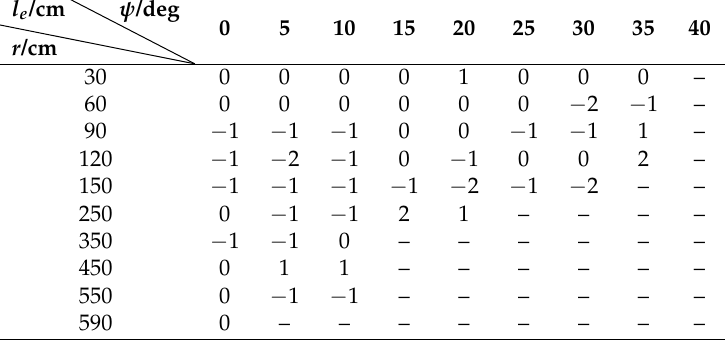
Table 4. Errors of multi-ray model at various angles and